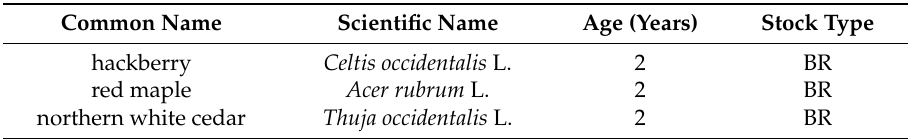
Table 3. Superior Municipal Forest species and seedling ages and planting stock type (BR—bare root,